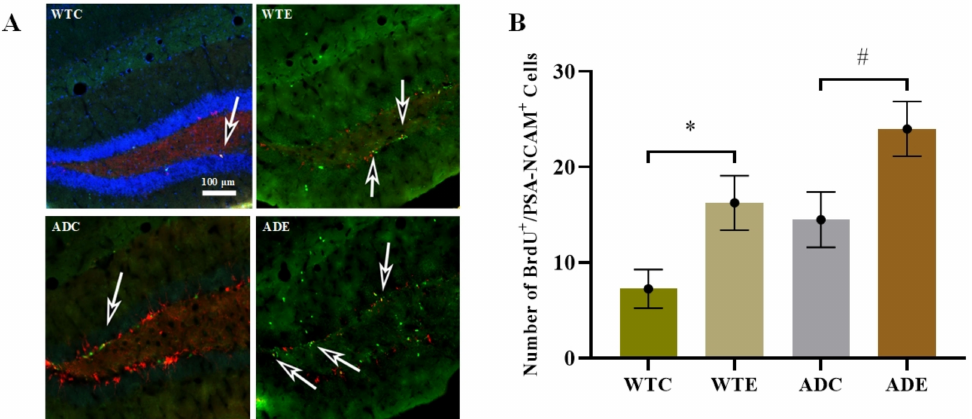
Figure 3. Effect of treadmill exercise on NSC proliferation in mice. ( A ) Fluorescence staining images of BrdU/PSA-NCAM- positive cells. The green, red and blue fluorescence represents the positive features of BrdU, PSA-NCAM and DAPI respectively. ( B ) Number of BrdU/PSA-NCAM-positive cells. n = 4 for each group. * p < 0.05 compared with WTC. # p < 0.05 compared with ADC. The arrows point to the BrdU/PSA-NCAM co-localization-positive